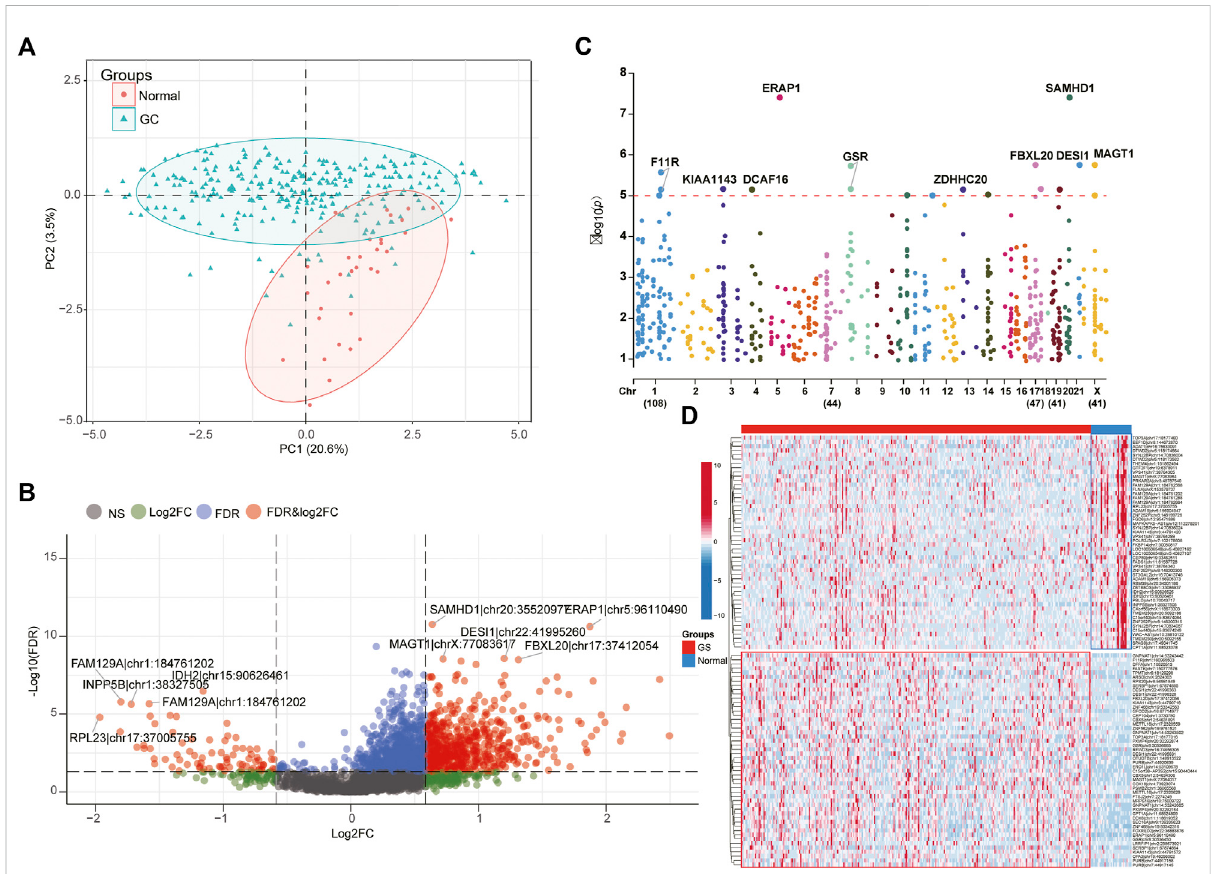
FIGURE 2 Identi fi cationofdifferentATIRE sitesbetweenSTADandHC. (A) PCAanalysisindicatedtheHCandSTADpatientsweresigni fi cantlydividedinto twocohortsbasedonATIRE sites. (B) VolcanoplotsshowingthedifferentATIRE sitesbetweenSTAD andHCcohorts. (C) Thetop5up-regulatedand down-regulated sites were displayed in the Manhattan diagram. (D) The heatmap revealed the expression levels of top50 up-regulated and down- regulated sites between two